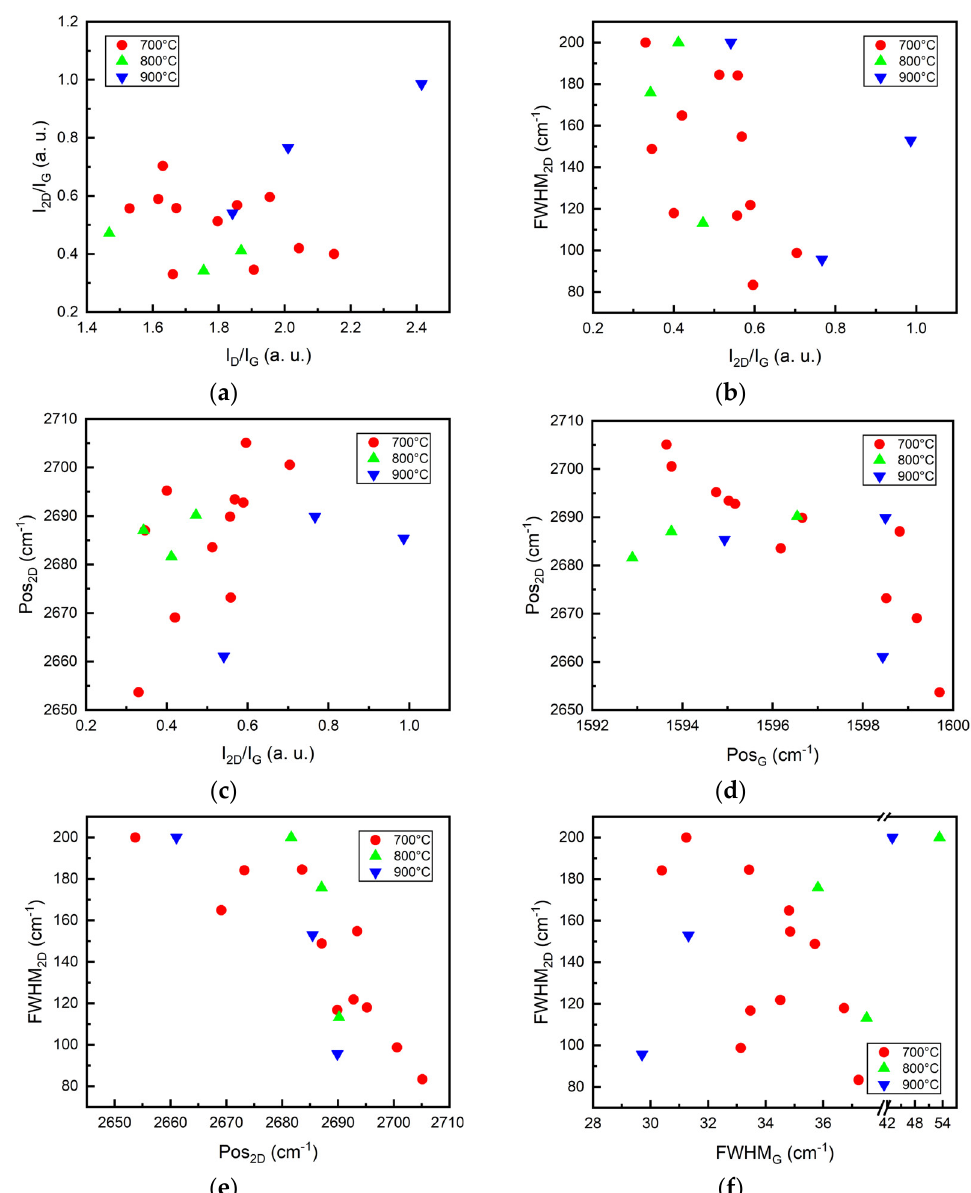
Figure 3. Relation between different Raman scattering spectra parameters: ( a ) I 2D /I G vs. I D /I G ; ( b ) FWHM 2D vs. I 2D /I G ; ( c ) Pos 2D vs. I 2D /I G ; ( d ) Pos 2D vs. Pos G ; ( e ) FWHM 2D vs. Pos 2D ; ( f ) FWHM 2D vs.